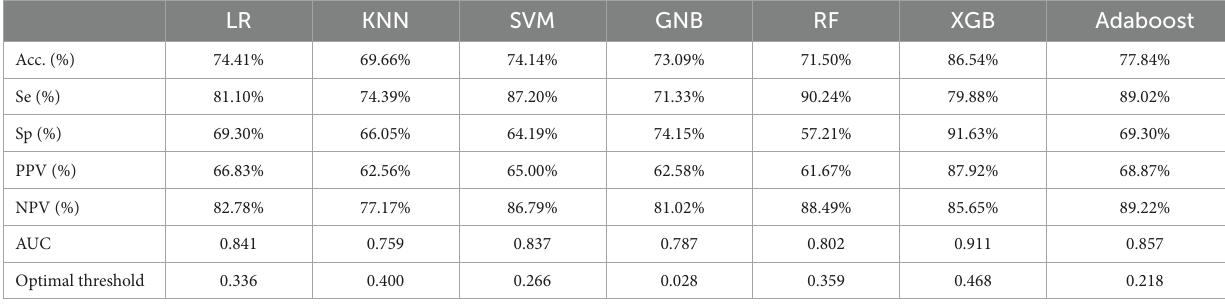
TABLE 7 Performance of classifier implementation on task 3.